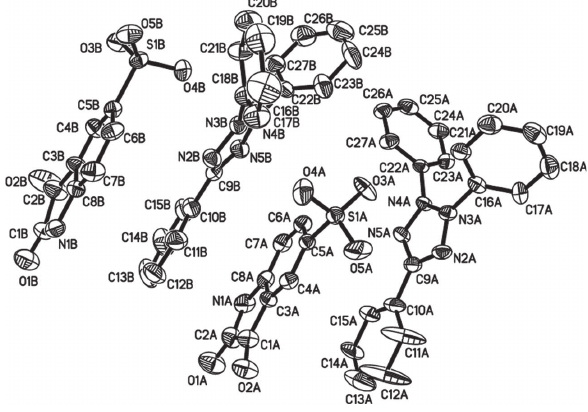
Table 1: Data collection and